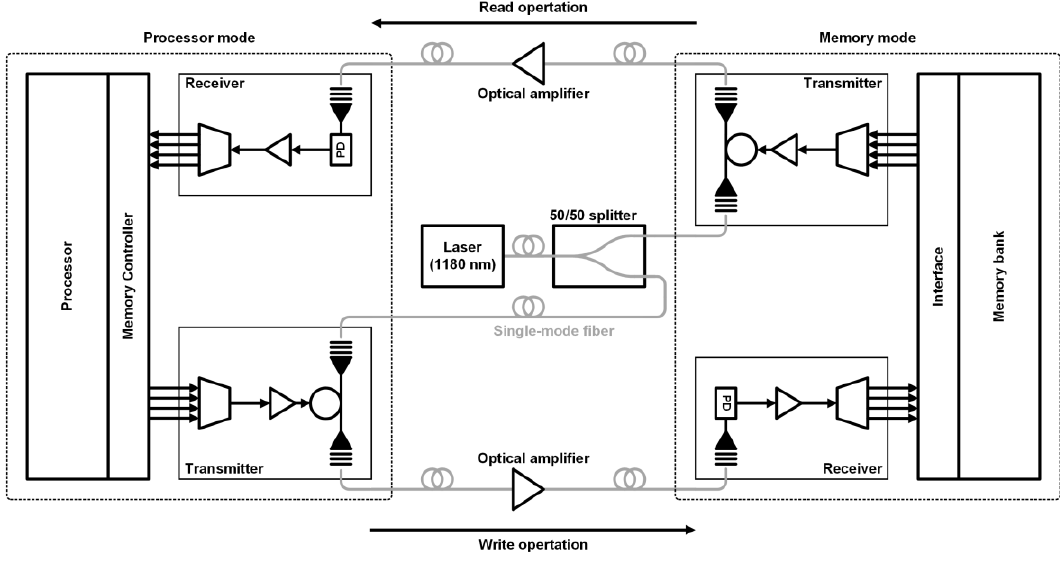
Figure 8. Block diagram of memory-processor optical link realized in [48].